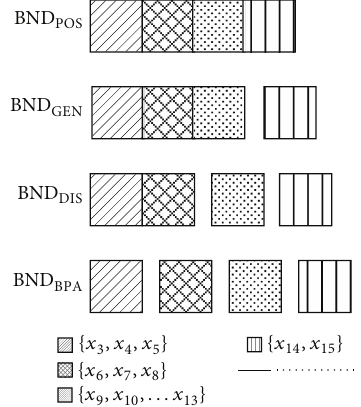
Figure 2: Boundary regions of five relative